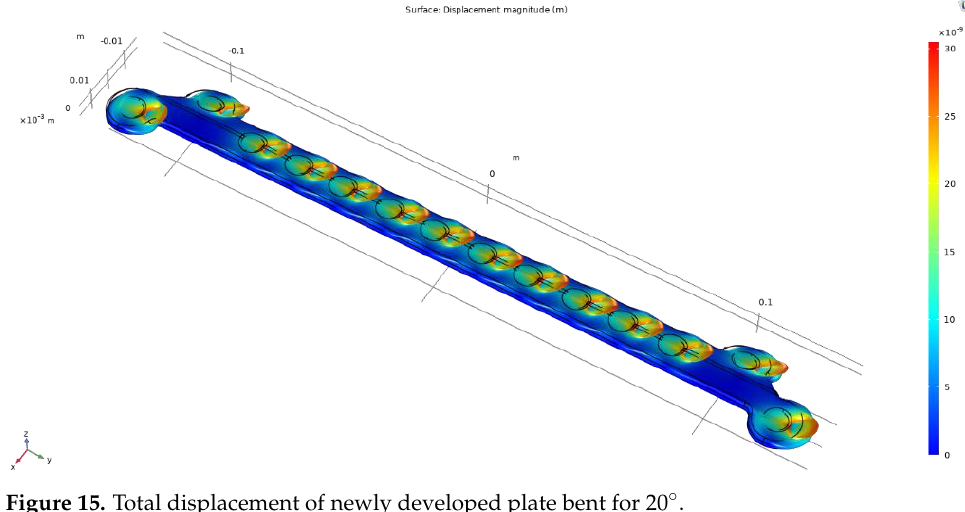
Figure 15. Total displacement of newly developed plate bent for 20°.